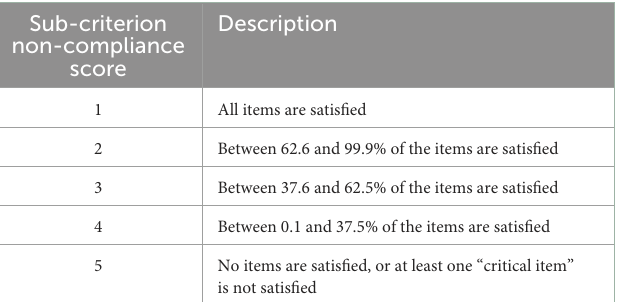
TABLE 3 Description of the sub-criterion non-compliance scoring